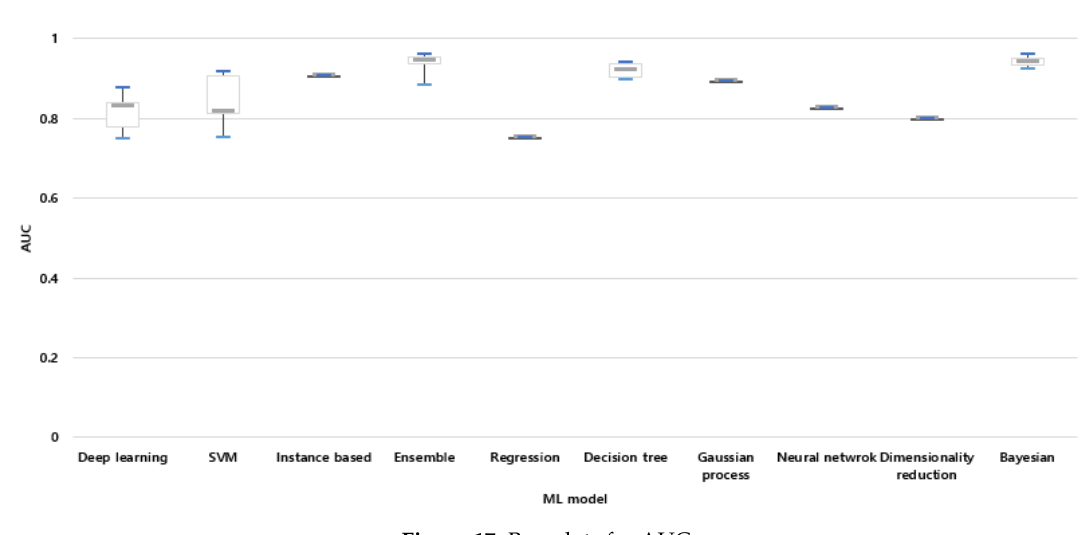
Figure 17. Box plots for AUC.